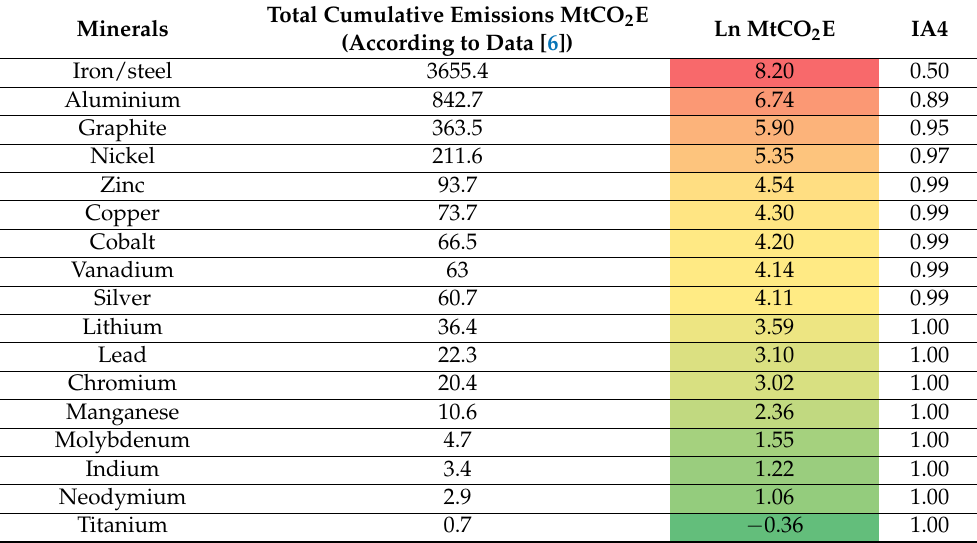
Table A4. Mineral ranking by cumulative CO 2 emissions which are associated with metal production.